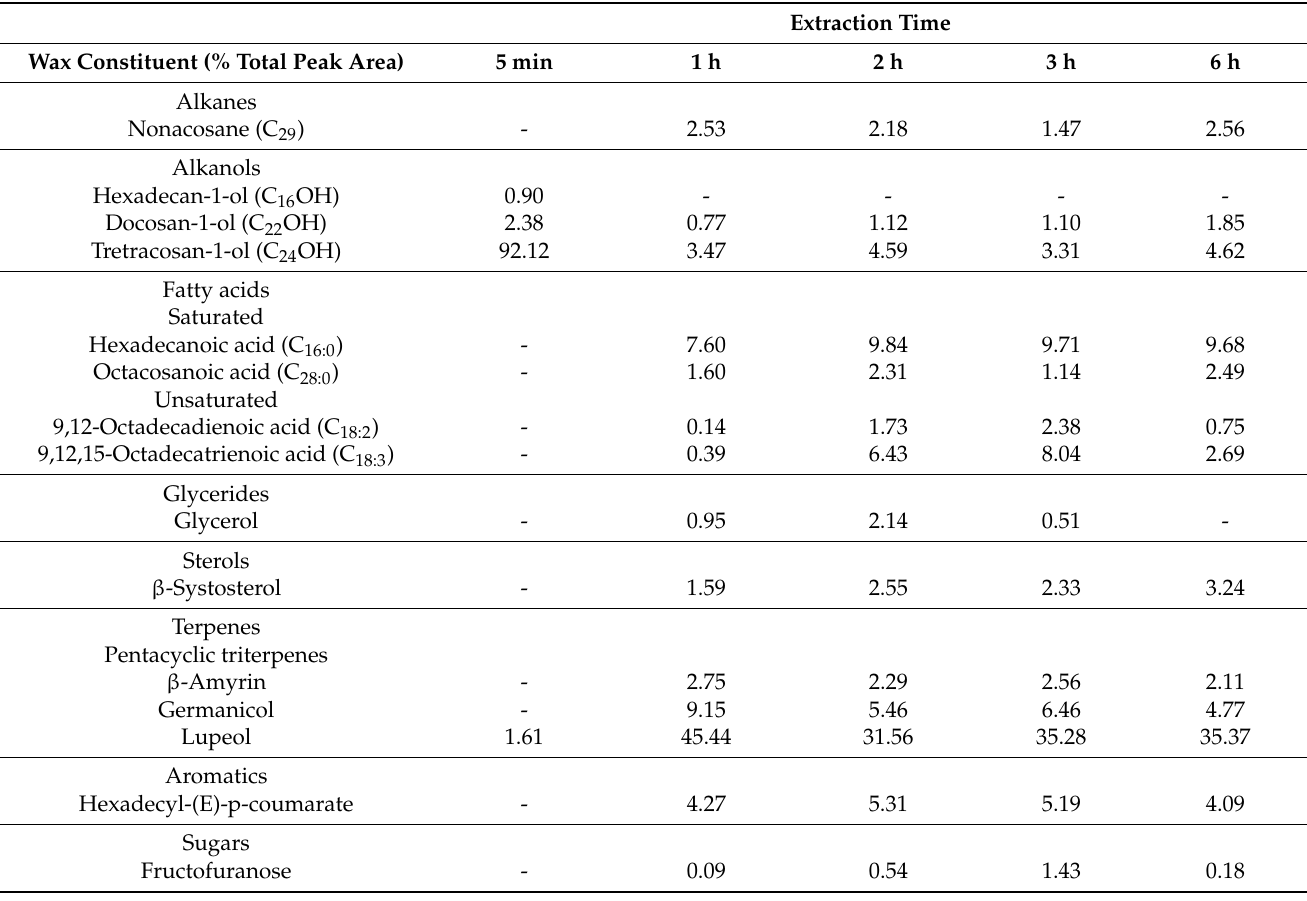
Table 4. Composition of the cuticular waxes of cork oak leaves solubilised in dichloromethane with different extraction times, as determined by GC–MS in % of total peak area (only compounds with over 1% are shown; complete composition in Supplementary Table S2).